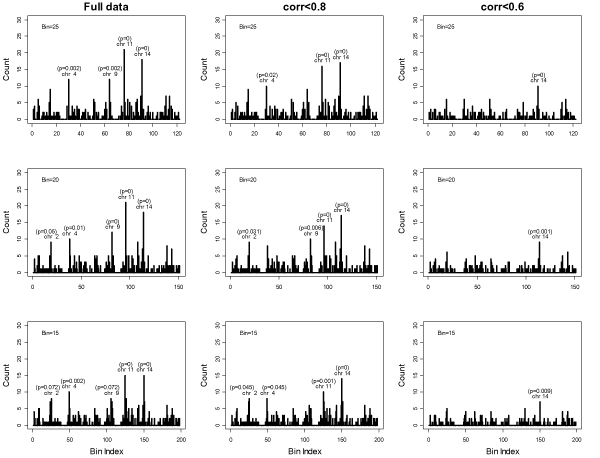
eQTL cluster with different bin sizes andcorrelation levels. LOD > 5.3. Only significant hot spots are highlighted with adjusted p-values.